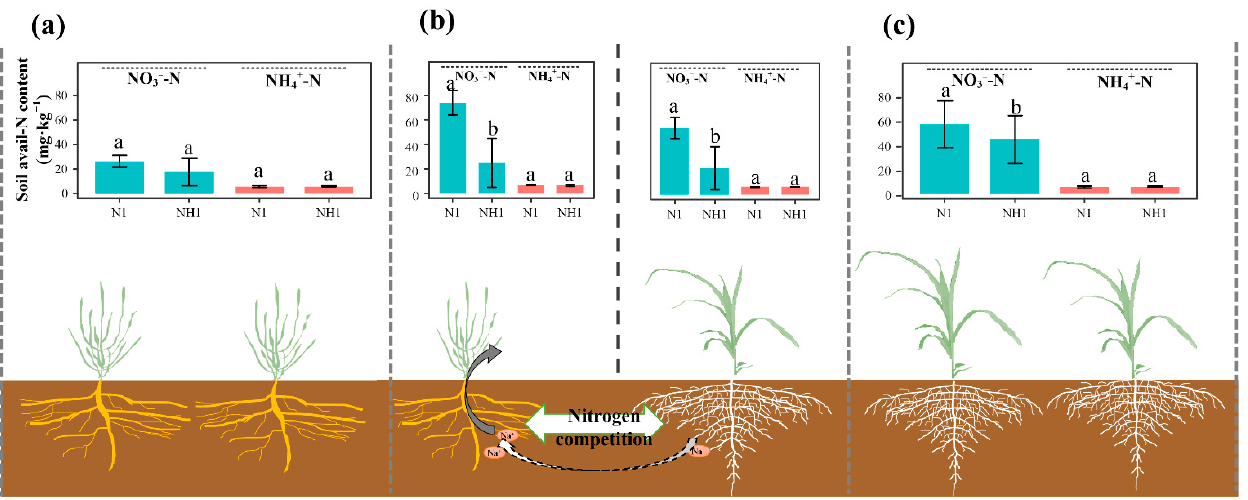
Figure 6. Variations in NO 3 − -N and NH 4+ -N content in the soil layer of S. salsa and Z. mays L. under N1 and NH1 treatments in the different cropping patterns. ( a – c ) Suaeda monoculture, suaeda/maize intercropping, and maize monoculture, respectively. Lower case letters indicate significant differences between two N treatments.